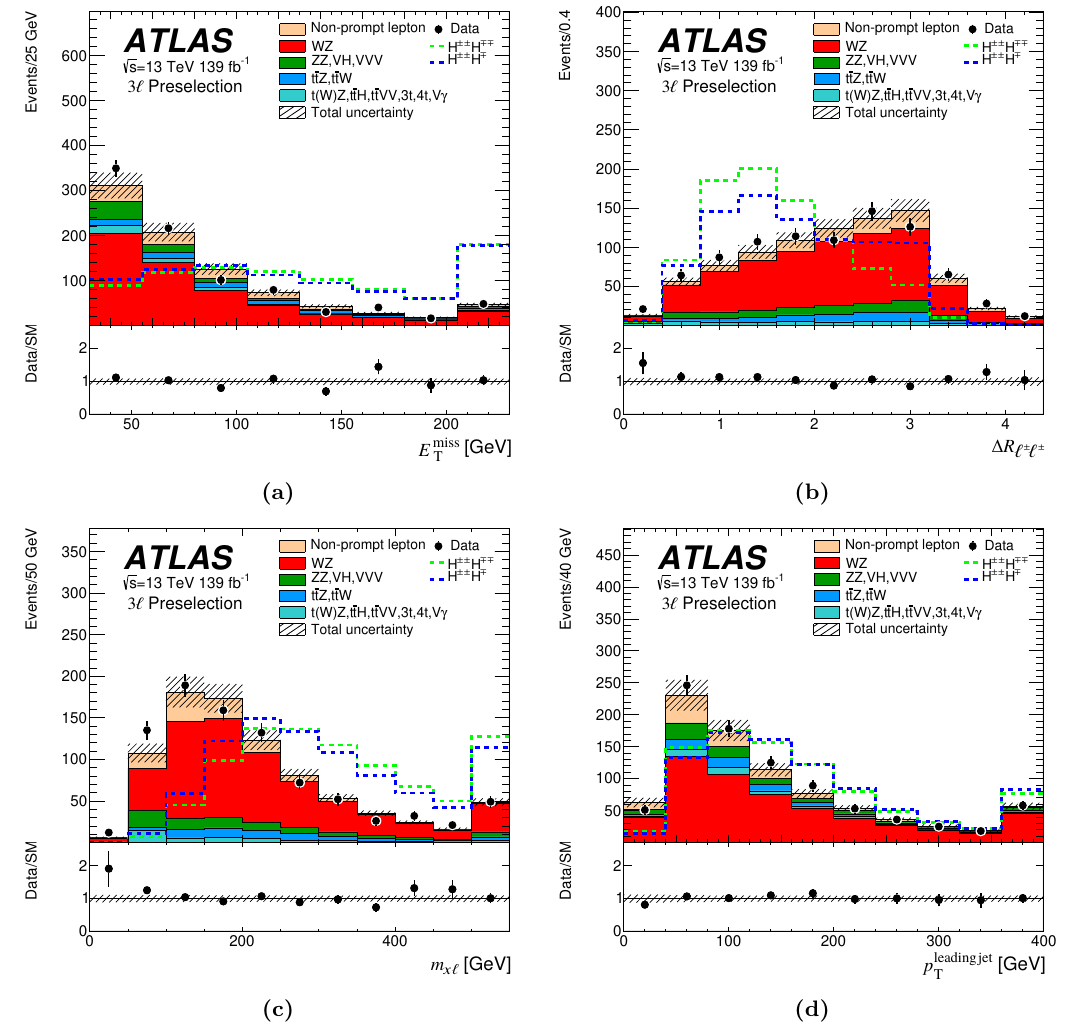
Figure 4 . Distribution of selected variables used to define the 3 ‘ SRs. The events are selected with the preselection requirements listed in table 4. The data (dots) are compared with the expected contributions from the relevant background sources (histograms). The expected signal distributions for m = 300 GeV are also shown, scaled to the observed number of events. The last bin includes H ±± overflows. In each figure the bottom panel shows the ratio of data to the estimated background. The hatched band around unity represents the total uncertainty of the